Question: Author a descriptive caption for the visualization shown.
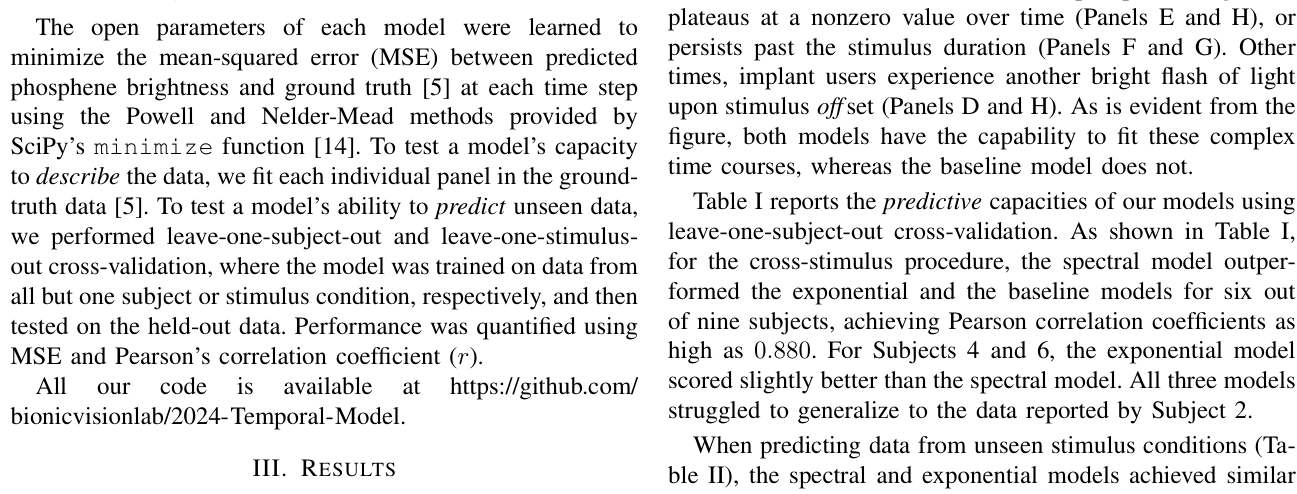
Answer: Model fits for representative time courses, each elicited by distinct electrical stimuli (see Table II for details). Subjects’ perceived brightness levels (gray; indicated by joystick position [5]) are depicted alongside predictions from three models: spectral (black), exponential (blue), and baseline [10] (orange).